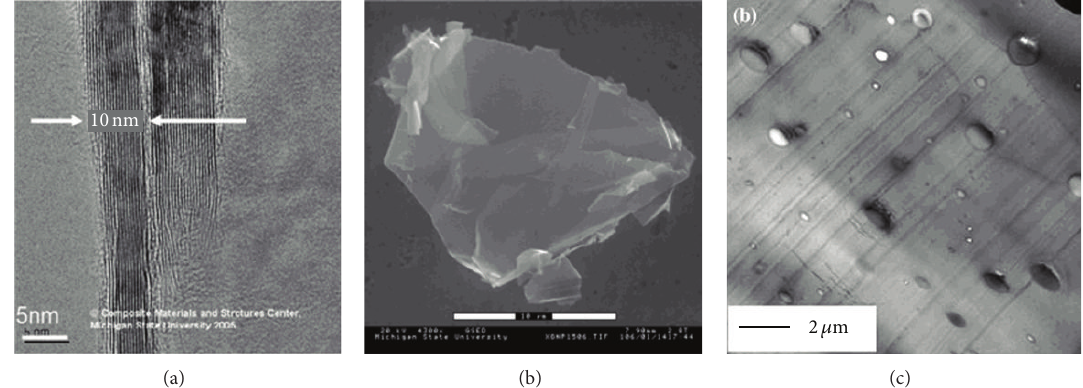
Figure 1: Typical SEM and TEM morphology of nanoparticle dispersion. (a) Edge view of xGnP flake [8], (b) lateral view of xGnP flake [8], and (c) globular CTBN particles [10].